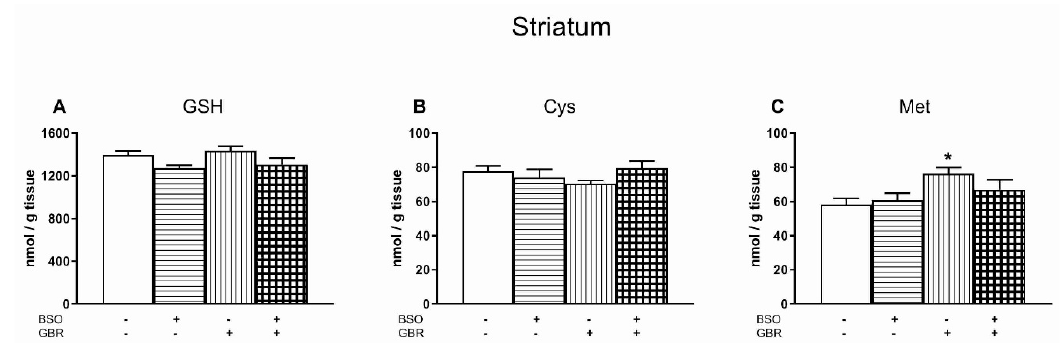
Figure 5. The e ff ects of chronic administration of BSO and / or GBR 12909 on the levels of GSH ( A ), Cys Figure 5. The effects of chronic administration of BSO and/or GBR 12909 on the levels of GSH ( A ), ( B ) and Met ( C ) in the striatum (STR) of pups. Data expressed in nmol / g of tissue are presented as Cys ( B ) and Met ( C ) in the striatum (STR) of pups. Data expressed in nmol/g of tissue are presented the mean ± SEM, n = 8 for each group. Symbols indicate significance of di ff erences according to the as the mean ± SEM, n = 8 for each group. Symbols indicate significance of differences according to the Bonferroni post-hoc test, * p < 0.05 vs. the control group. Bonferroni post-hoc test, * p < 0.05 vs. the control group.